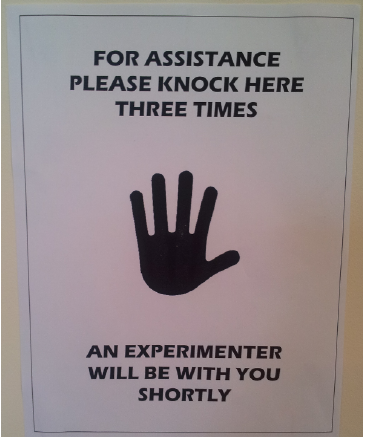
Figure 5: Sign instructing participants what to do in case they needed help.